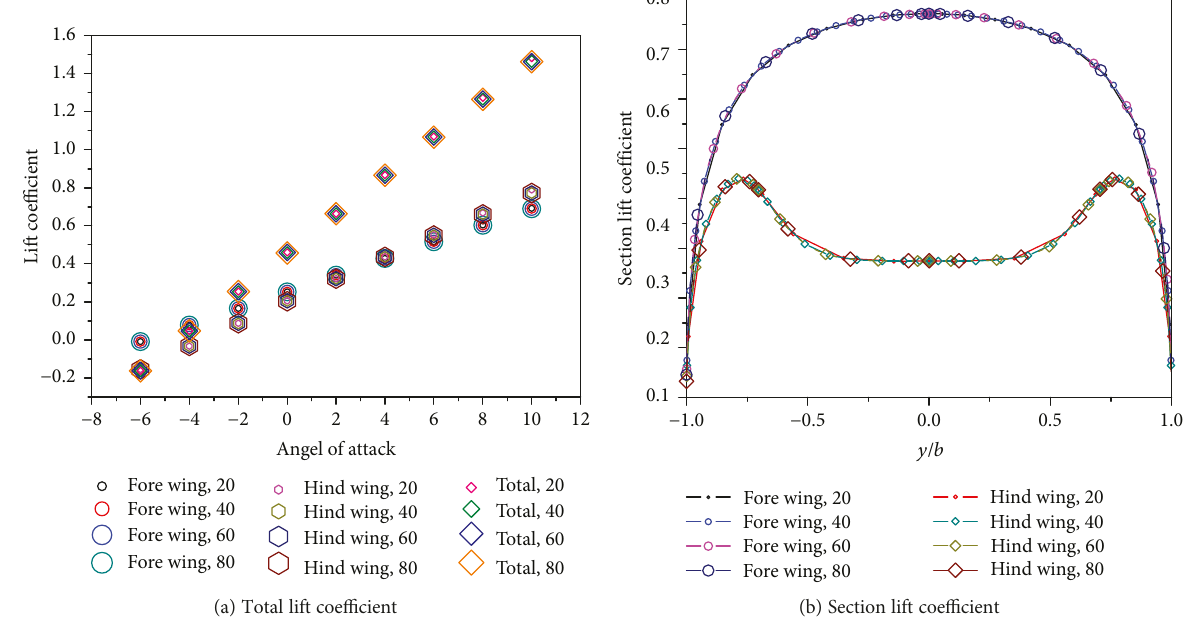
Figure 9: Grid sensitivity